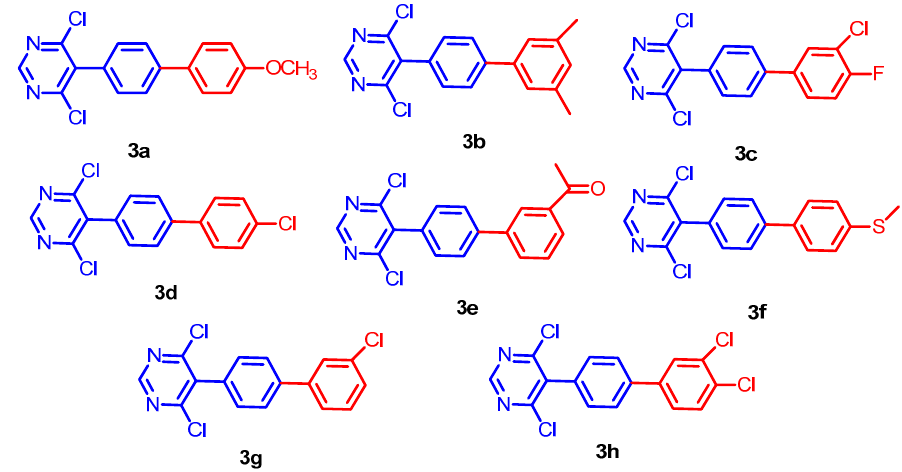
Figure 1. Pyrimidine derivatives (3a–3h) obtained by Suzuki cross-coupling using 5-(4- bromophenyl)-4,6-dichloropyrimidine as the coupling